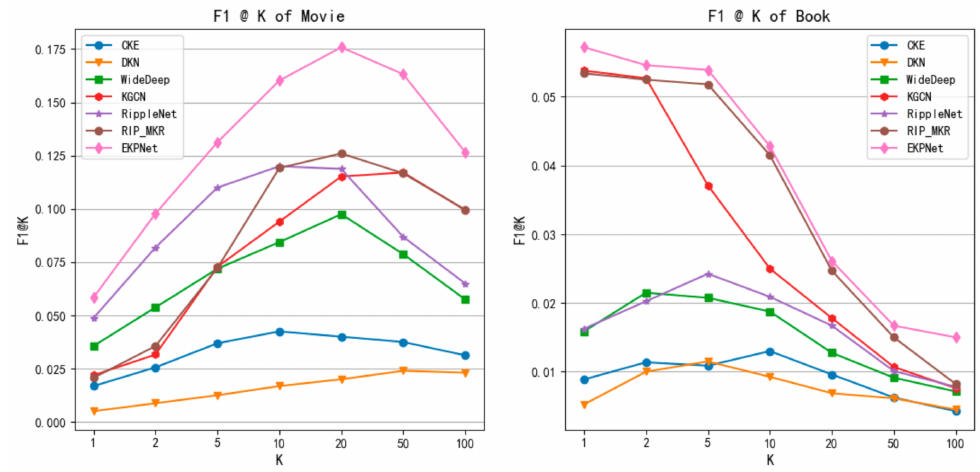
Figure 6. F1@K of different baselines in the two datasets in the topK task.